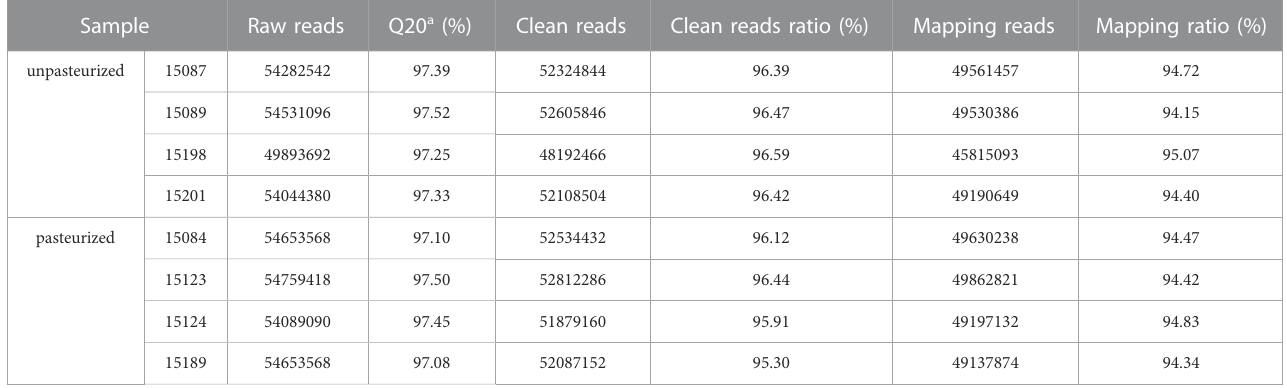
TABLE 2 Quality analysis of sequencing